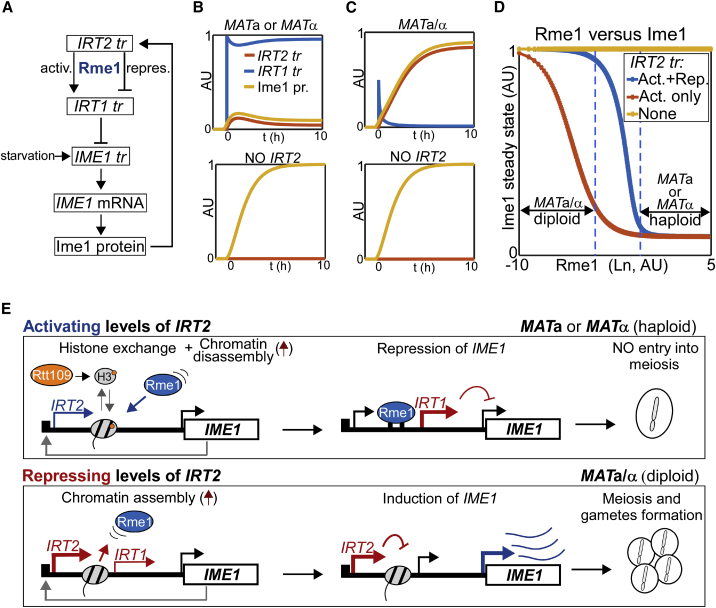
Modeling of cell-type-specific control of Ime1 expression involving noncoding transcription(A) Scheme of the mathematical model.(B and C) Simulation of MATa and MATa/α cells in the presence or absence of IRT2.(D) Simulation of Ime1 steady-state protein levels over a range of Rme1 concentrations (Ln), in the presence of either WT levels of IRT2 (activating and repressive effects on IRT1), activating levels of IRT2 (activating effect on IRT1 only), or no IRT2.(E) Model describing how distinct levels of IRT2 control the decision of whether to enter meiosis and form gametes in haploid (MATa or MATα) and diploid (MATa/α) cells.